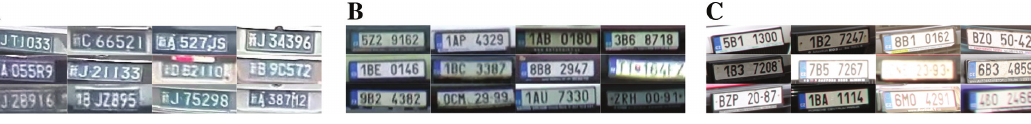
Figure 6: Example Images of Three Datasets: (A) XJ_ReId, (B) ReId, and (C)